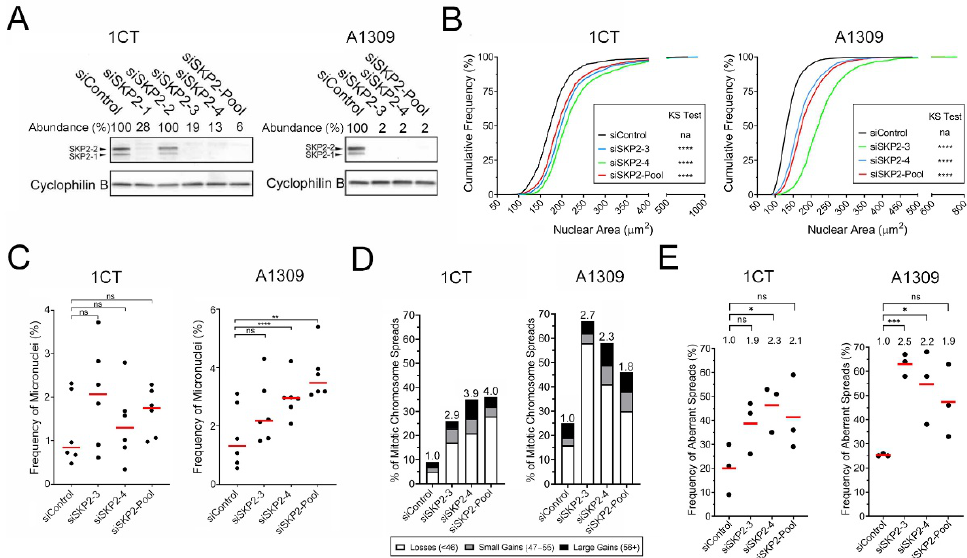
Figure 5. SKP2 silencing in 1CT and A1309 cells corresponds with increases in CIN-associated phenotypes. ( A ) Semi-quantitative Western blots depicting reduced SKP2 abundance following silencing relative to siControl in 1CT (left) and A1309 (right) cells. ( B ) Cumulative distribution frequency graphs reveal statistically significant increases in nuclear areas following SKP2 silencing (two-sample KS tests; na, not applicable; ****, p -value < 0.0001; N = 3, n = 6). ( C ) Dot plots depicting trending (1CT) and significant (A1309) increases in the frequency of micronuclei following SKP2 silencing relative to siControl (MW test; ns, not significant, p -value > 0.05; **, p -value < 0.01; ****, p -value < 0.0001; N = 3, n = 6) ( D ) Bar graphs depicting the frequency of spreads with aberrant chromosome numbers following SKP2 silencing. Fold increase relative to siControl is presented at the top of each column (N = 3, n = 100 spreads/condition). ( E ) Dot plots reveal significant increases in the frequency of total aberrant chromosome spreads following SKP2 silencing relative to siControl; fold increase relative to siControl is indicated. (Student’s t -test; ns, not significant, p -value > 0.05; *, p -value ≤ 0.05; *** = p -value < 0.001; N = 3, n = 100/condition).